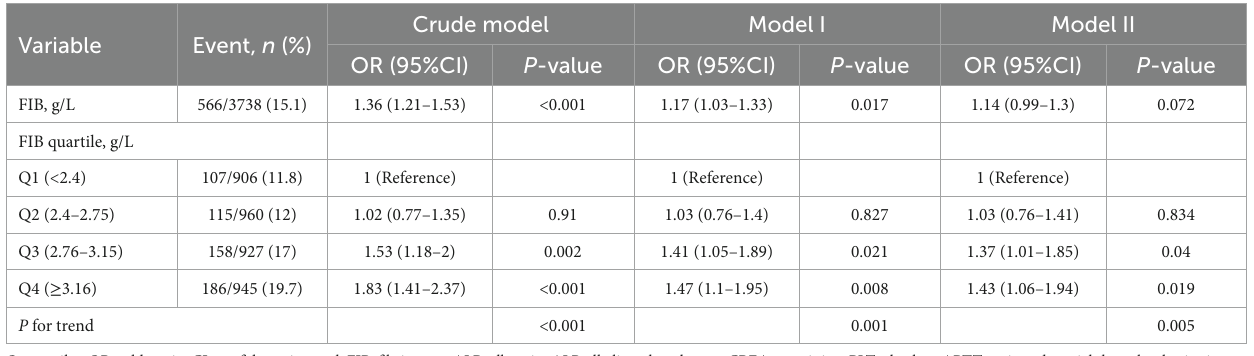
TABLE 2 Multivariable logistic regression analyses of fibrinogen and advanced colorectal adenoma.